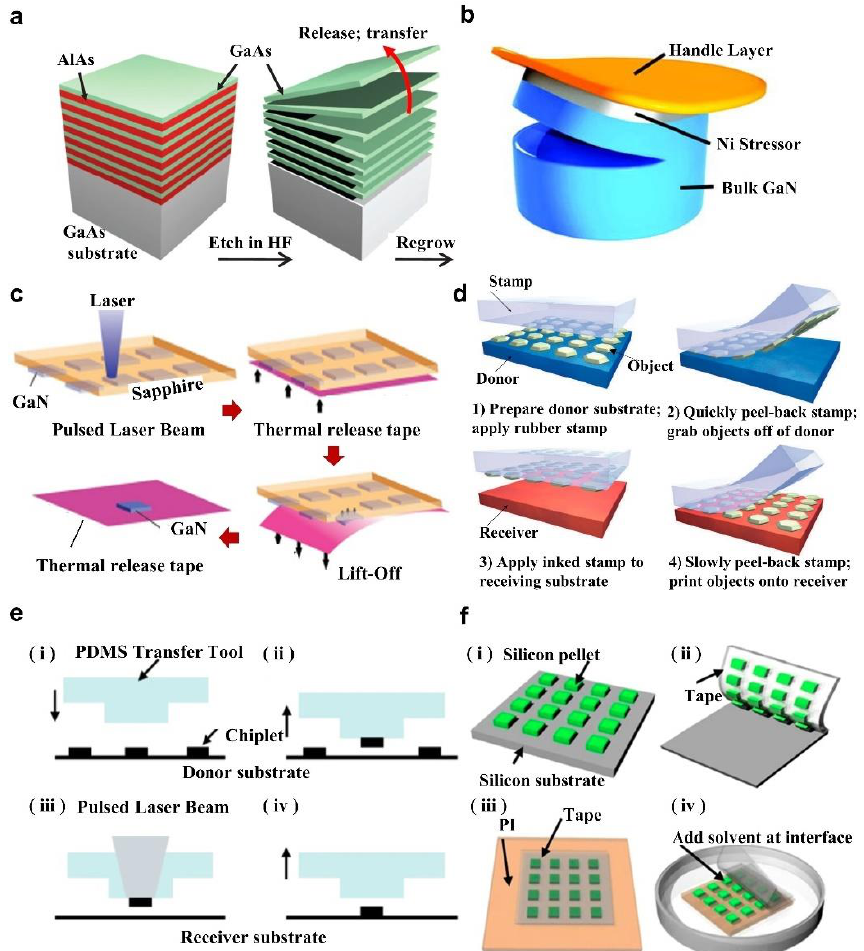
Figure 1. The heterogeneous integration with epitaxial lift-off techniques and representative transfer printing techniques. ( a ) Schematic illustration of the release of the thin GaAs layer by selective removal of the sacrificial layer based on the wet etching process. Reproduced with permission from Ref.